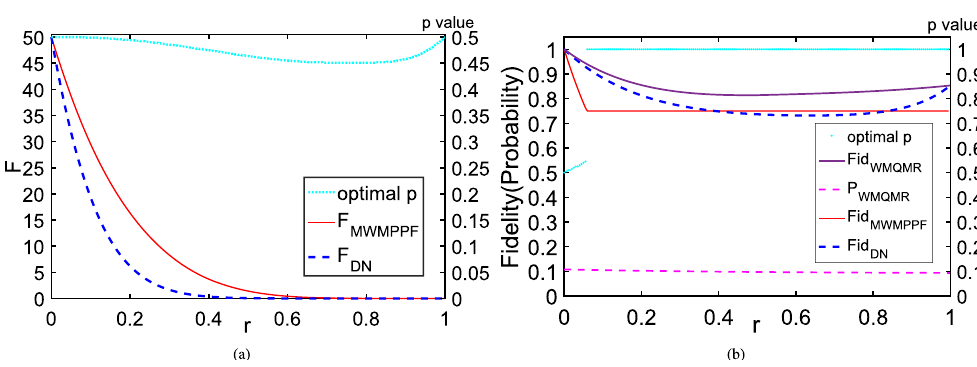
Figure 5. ( a ) Average QFI and the optimal p vs. r with N = 10, θ = π /4. (1) F MWMPPF (red full line) is the maximum of F WMPPF by choosing the optimal p value as r varies; (2) the optimal p value for average QFI of F MWMPPF (celeste dotted line) according to r can be drawn at the same parameters with the coordinate scale on the right edge of the figure; (3) F DN (blue dashed line) for DN case. ( b ) Average fidelity and the optimal p and probability vs. r with N = 10, θ = π /4. (1) Fid WMQMR (purple full line) is the average fidelity of WMQMR, we provide its p 1 = p r = 0.2 as an example and its probability is: (2) P WMQMR (magenta dashed line) with the same parameters; (3) Fid MWMPPF (asterisk line); (4) the optimal p value for Fid MWMPPF (celeste dotted line) as r varies; (5) Fid DN (blue dashed